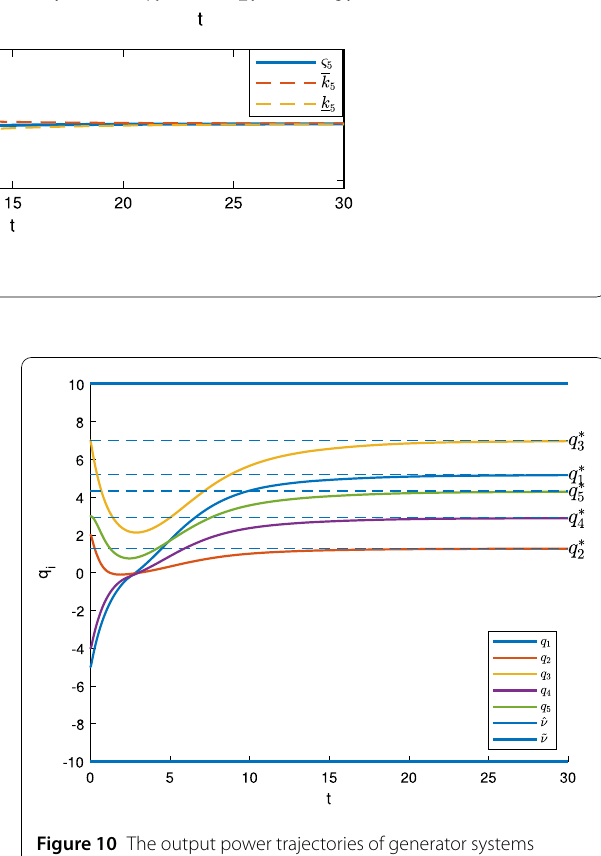
Figure 10 The output power trajectories of generator systems (33a)–(33b) under the proposed